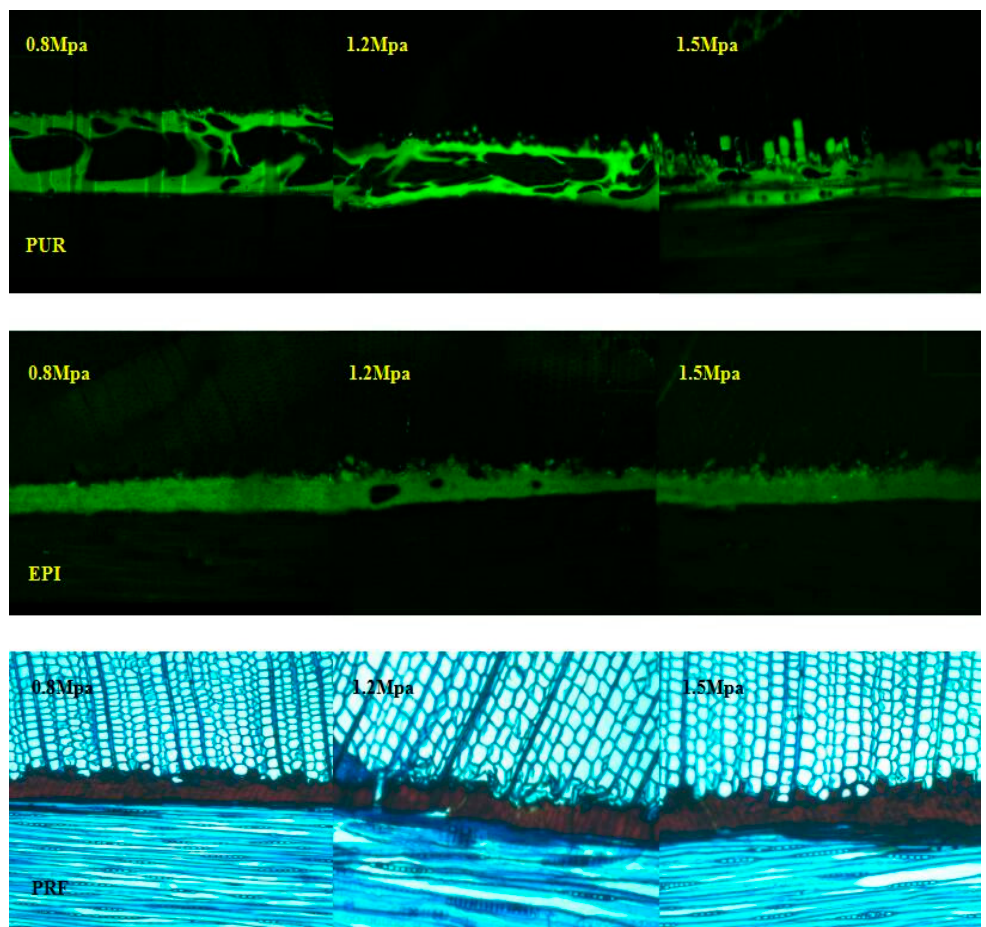
Figure 4. Fluorescence and optical microscope photomicrographs with transverse view of horizontal bond lines showing the penetration of adhesives.